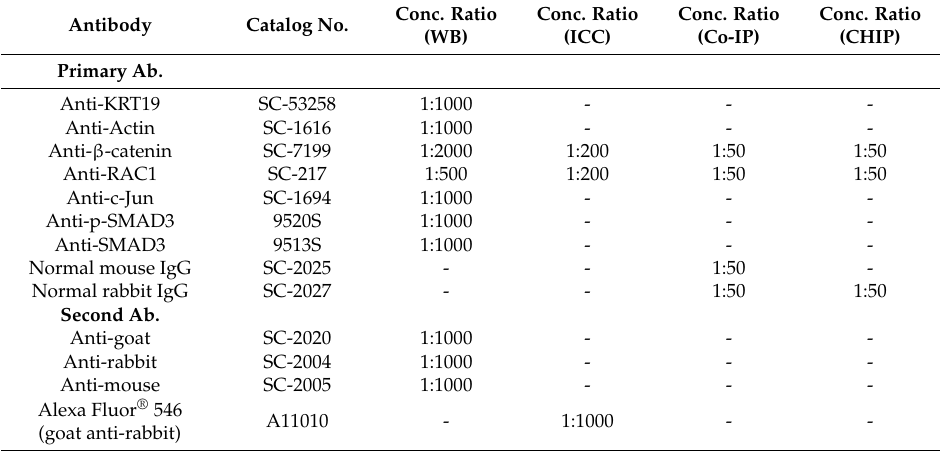
Table 2. List of antibodies used for quantification of specific protein expression (WB), ICC, Co-IP, and ChIP